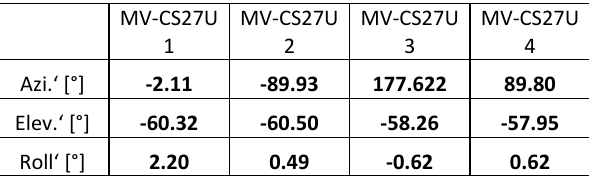
Table 2: Viewing directions of oblique looking cameras in relation to nadir camera for a normal flight coordinate system Kremer, J., 2010. The Quattro DigiCAM - IGI's Versatile – Aerial Camera System for Various Aerial Imaging Tasks. In: Seyfert, E. [ed], DGPF-Publikationen, Deutsche Gesellschaft für Photogrammetrie, Fernerkundung und Geoinformation (DGPF) e.V., Oldenburg, S.